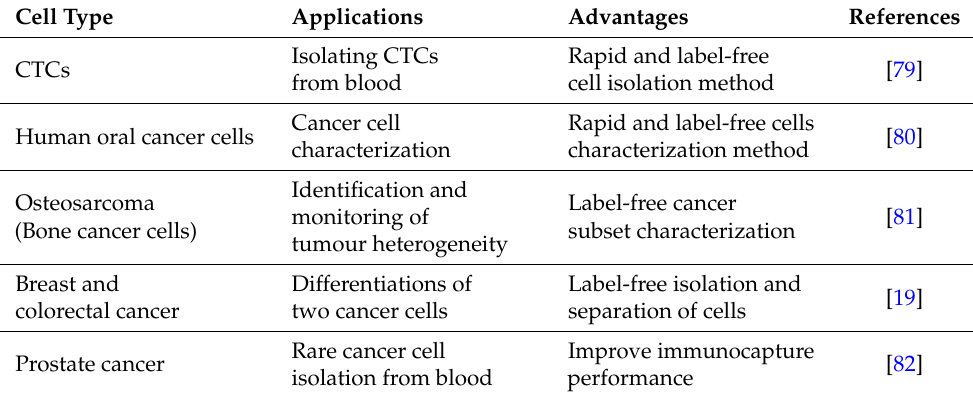
Table 3. DEP investigations in